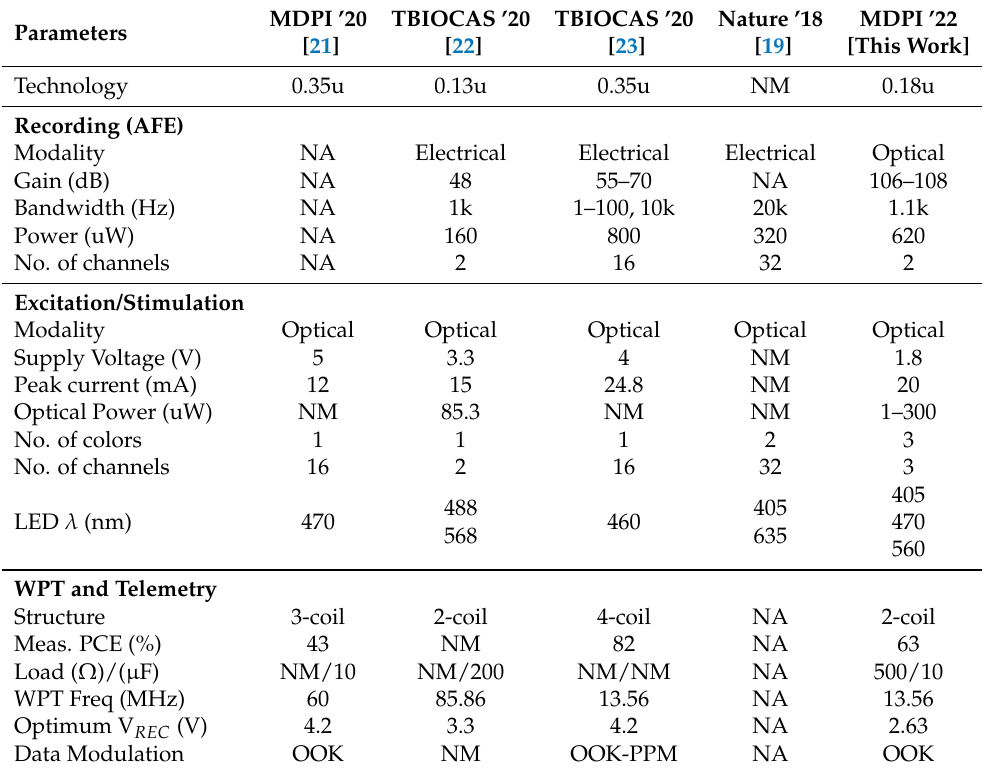
Table 1. Comparison with state-of-the-art